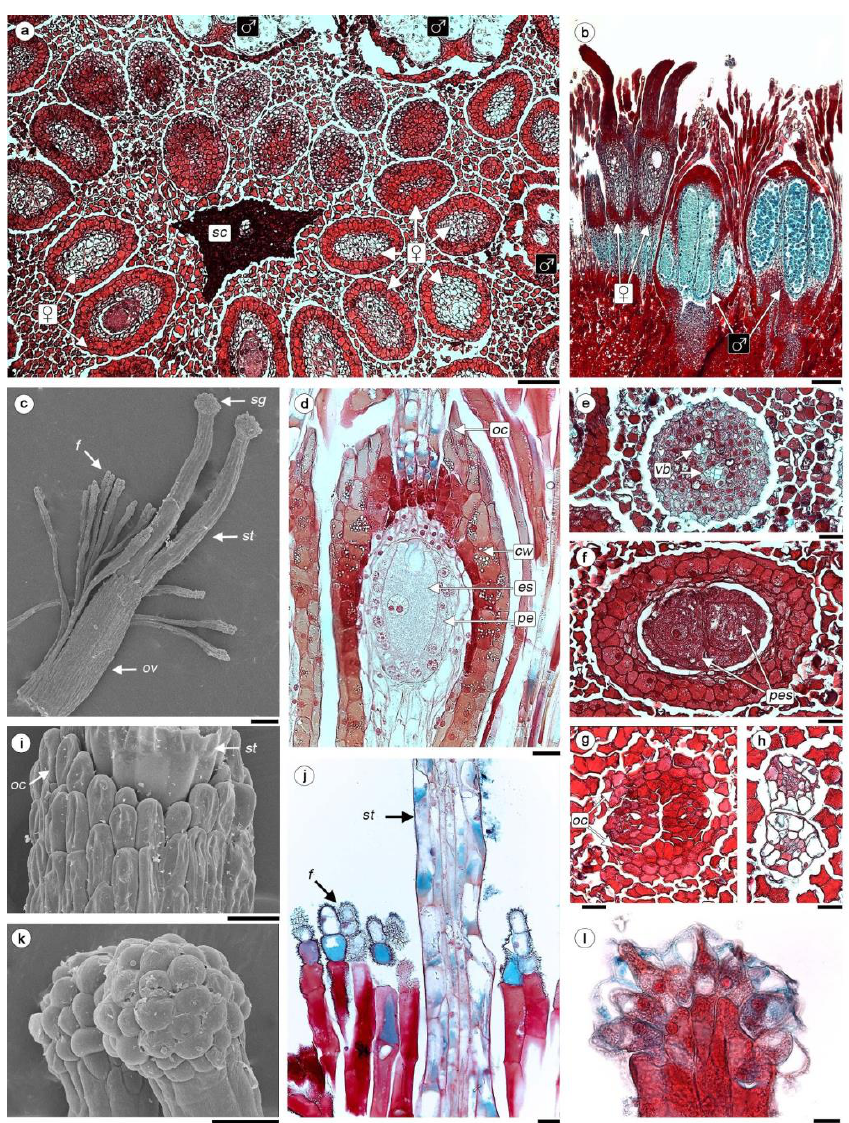
Figure 2. Anatomy of flowers of H. cayennensis (LM). ( a ) Paradermal section of inflorescence showing female and male flowers disposition around scale base, all the spaces between flowers are occupied by filariae. ( b ) Longitudinal sections (LS) of inflorescence in the area corresponding to a group of female and male flowers. ( c ) Female flower at embryo sac stage with same filariae attached. ( d ) LS of ovary with mature 4-celled embryo sac and pseudo-endothelium. ( e – h ) Serial TS of female flowers, ( e ) Pedicel of flower with vascular bundles, ( f ) ovary with 2 embryo sacs, ( g ) base of styles and ovary crest ( h ) styles. ( i ) Crest at apex of ovary. ( j ) LS with part of style and filariae. ( k ) Stigmata. ( l ) LS of stigmata. Abbreviations: ♀ : female flowers; ♂ : male flowers; vb: vascular bundles; cw: carpellar wall; es: embryo sac; f: filariae; oc: ovary crest; ov: ovary; pes: pair of embryo sacs; pe: pseudo-endothelium; sc: scale; sg: stigmata; st: style. Scale bar = ( a – c ) 0.2 mm, ( c – i ) 50 µm, ( j – l ) 20 µm.